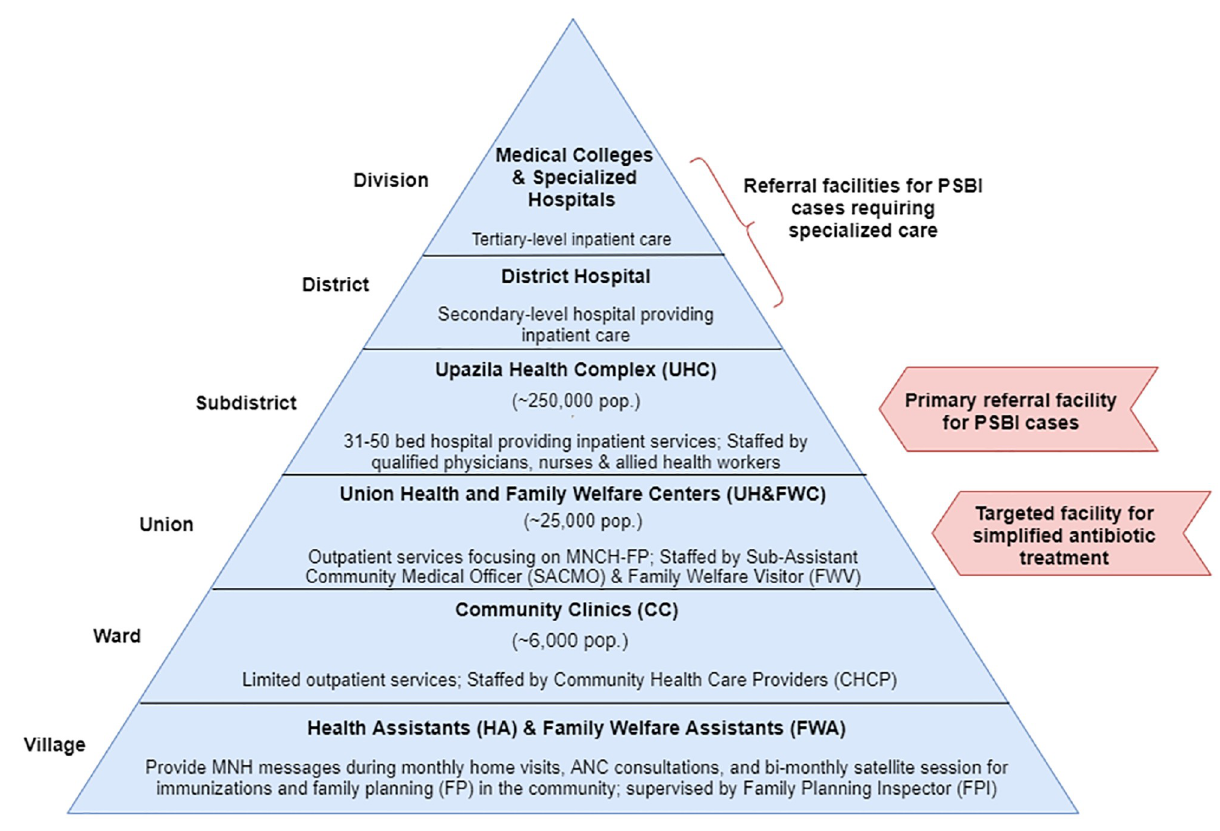
Fig 1. Provision of public health services relevant to management of PSBI in young